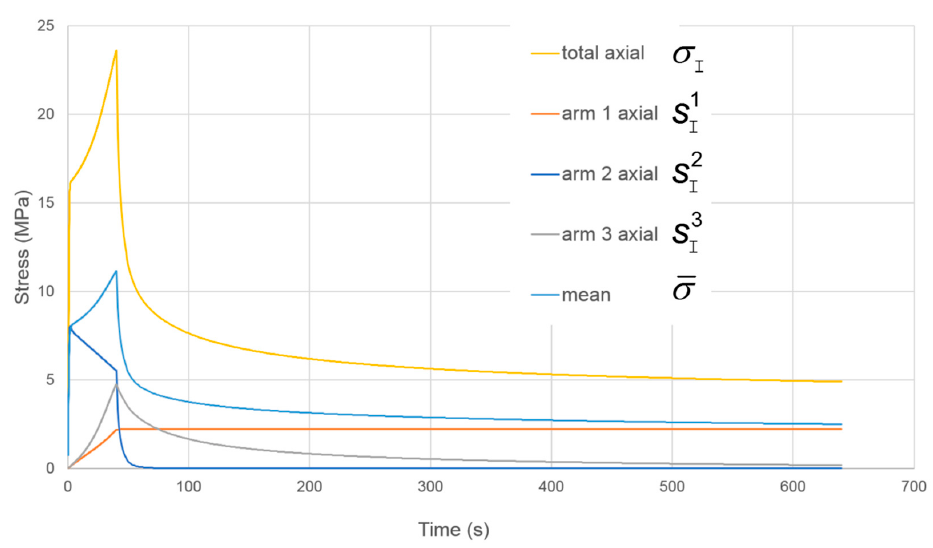
Figure 8. Stress components for the model of Figure 7.